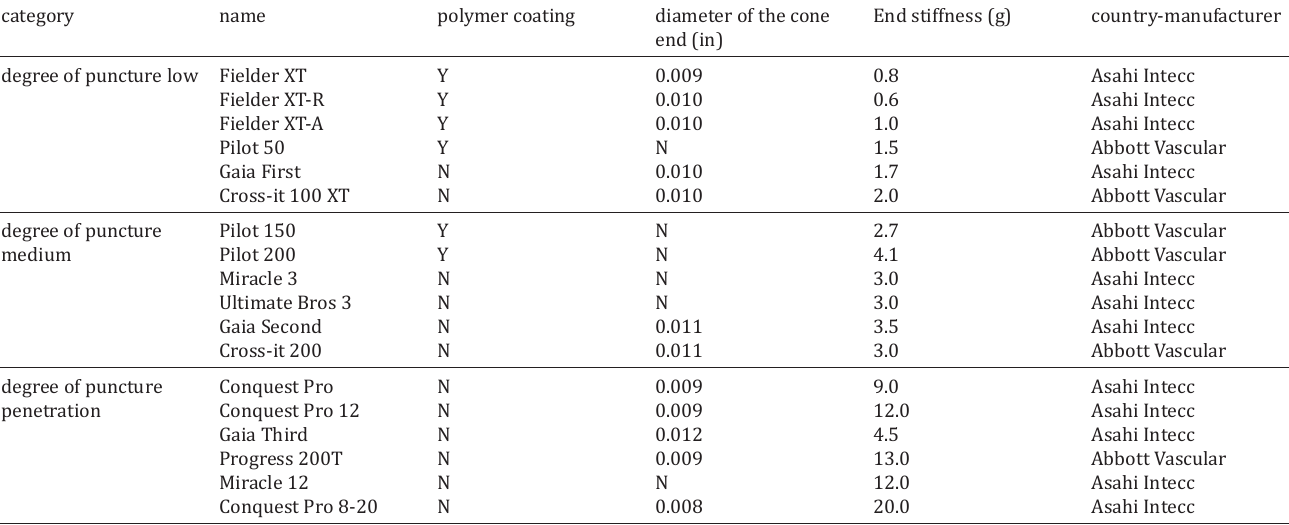
Frequently used guide wire by